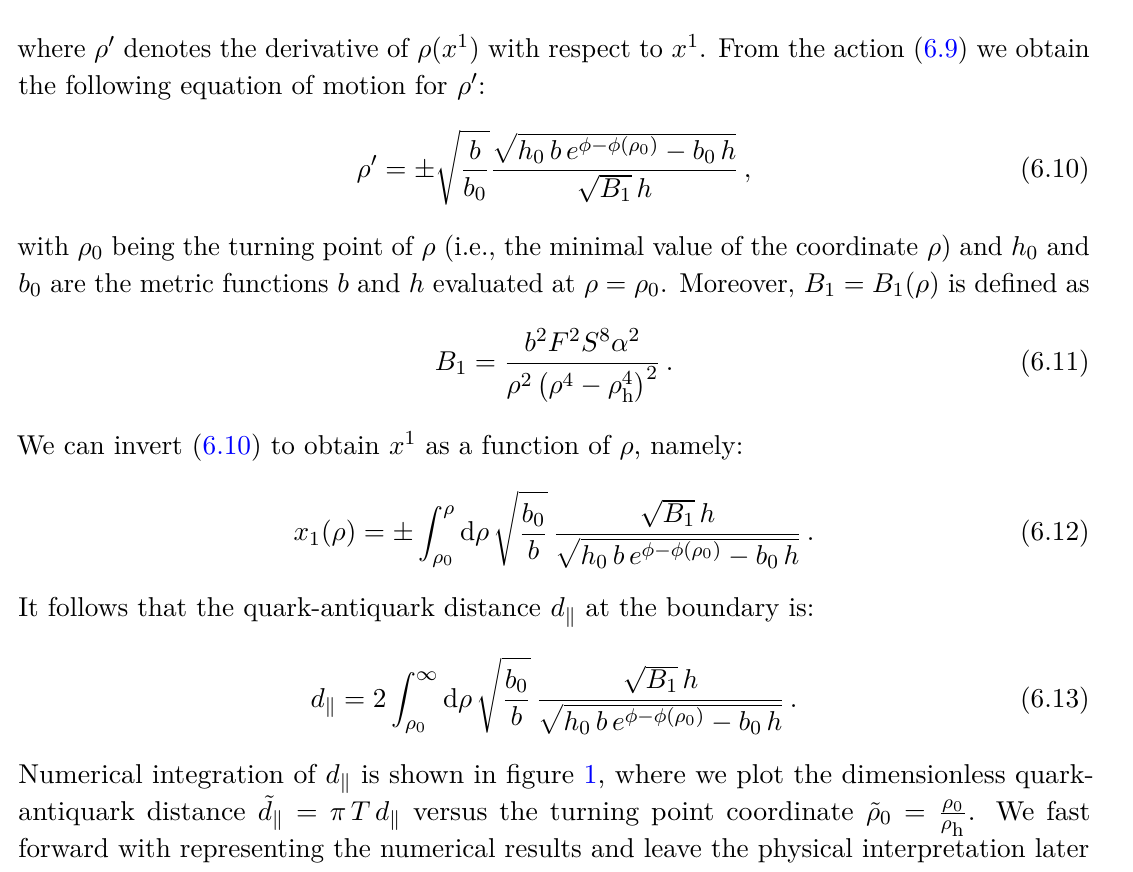
Figure 1 . Quark-antiquark distances ˜ d for different (cid:15) at fixed ˜ δ